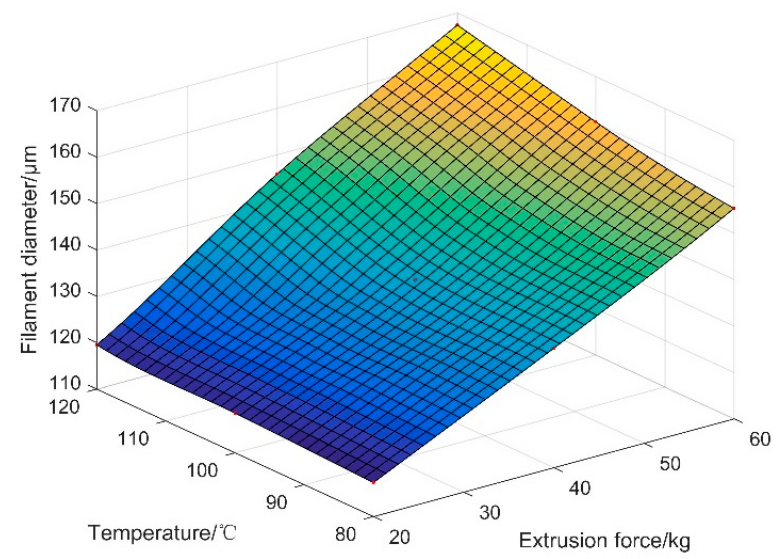
Figure 8. Surface fitting of the experimental data.